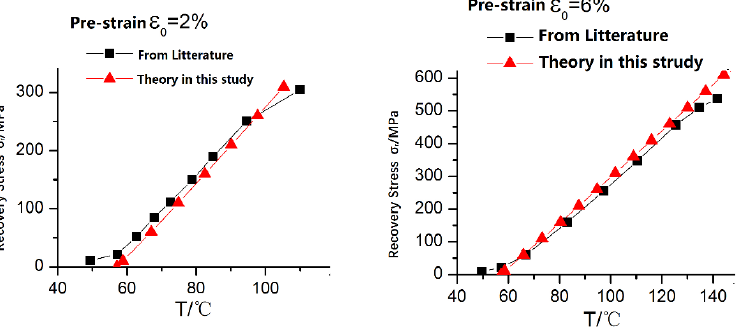
Figure 1. Comparison of the results between constitutive model theory and literature.